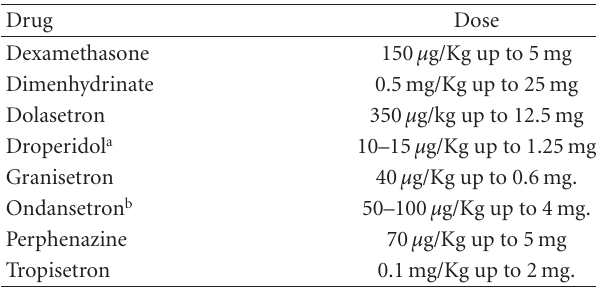
Table 3: Antiemetic doses for prophylaxis of postoperative vomit- ing (POV) in